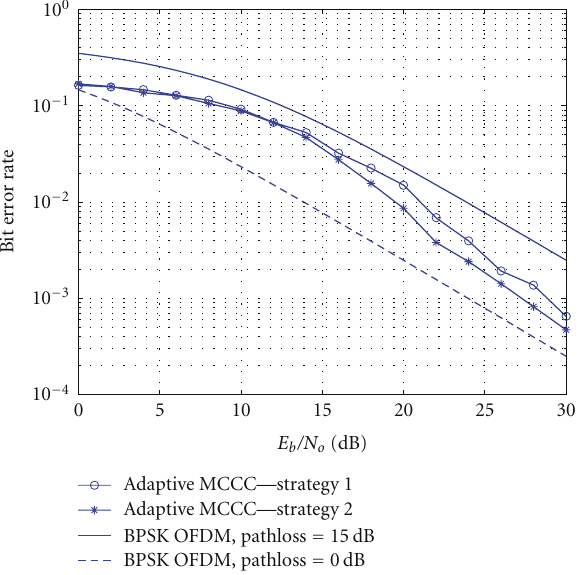
Figure 14: Bit error rate performance of adaptive MCCC technique of the first and second subcarrier allocation strategies where path- loss for TD and TR links is 15 dB and 20 dB,